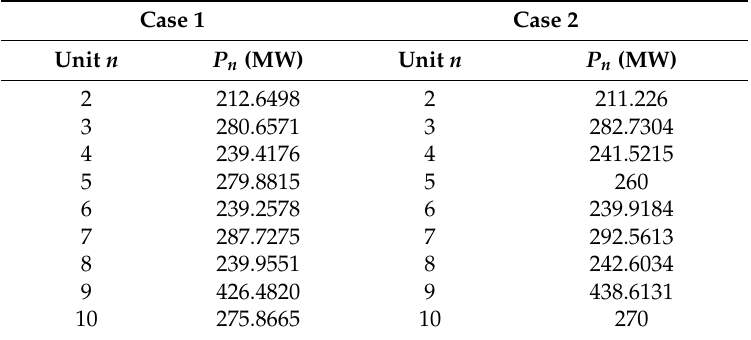
Table A2. The best decision variables for system 2 found by the proposed